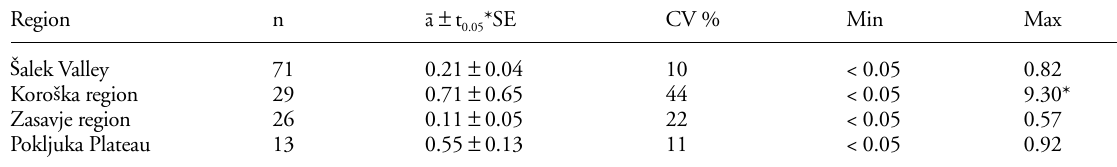
* Secondary contamination by lead bullet. Liver direct hit by the bullet were not included in the